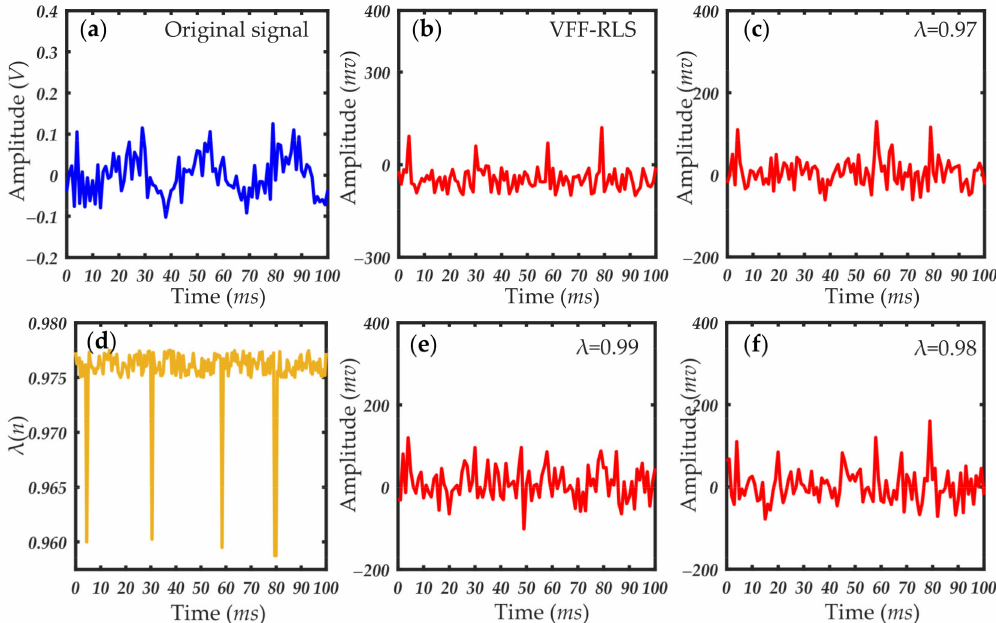
Figure 9. Particle scattering signal and filtering results (particle size: 0.2 µ m): ( a ) original scattering signal; ( b ) particle scattering signal processed by the VFF-RLS algorithm; ( d ) change curve of forgetting factor; ( c , e , f ) results of RLS algorithm with fixed forgetting factors, which are 0.97, 0.99, and 0.98,